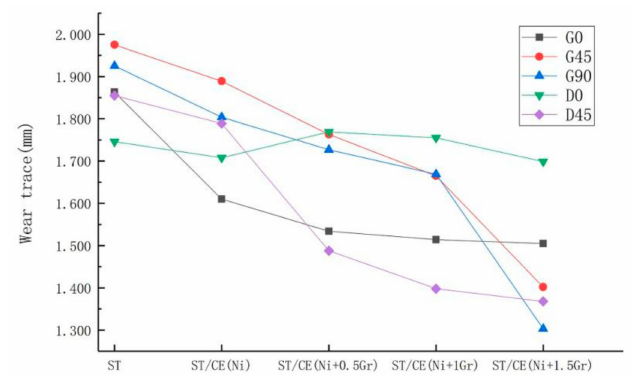
Figure 13. Variation of worn trace width on the surface of di ff erent treatment